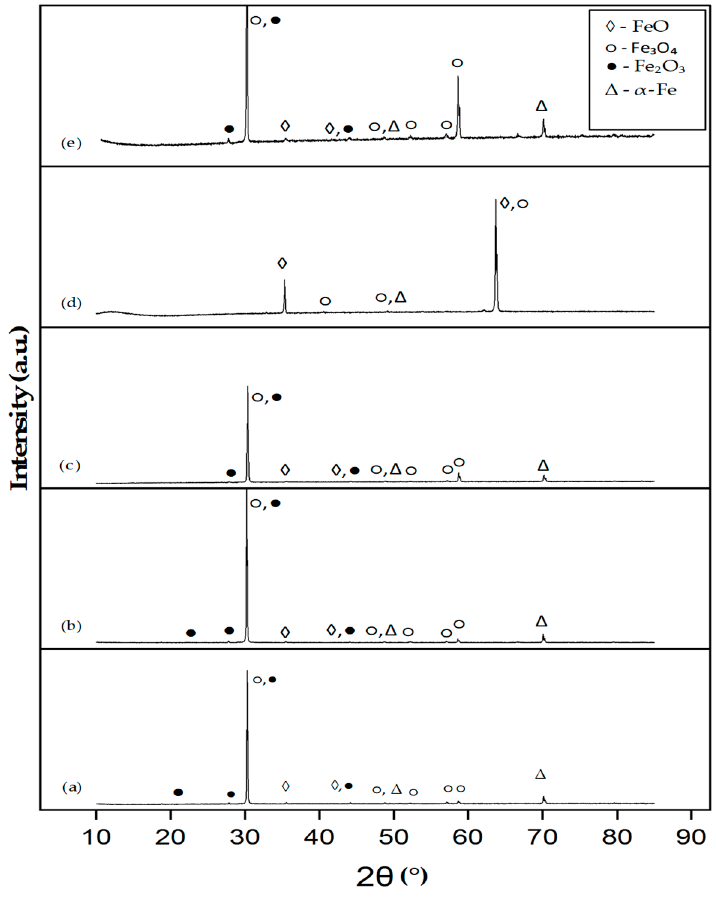
Figure 2. XRD patterns for EN8 after ( a ) 24, ( b ) 48, ( c ) 72, ( d ) 96 and ( e ) 120 h.